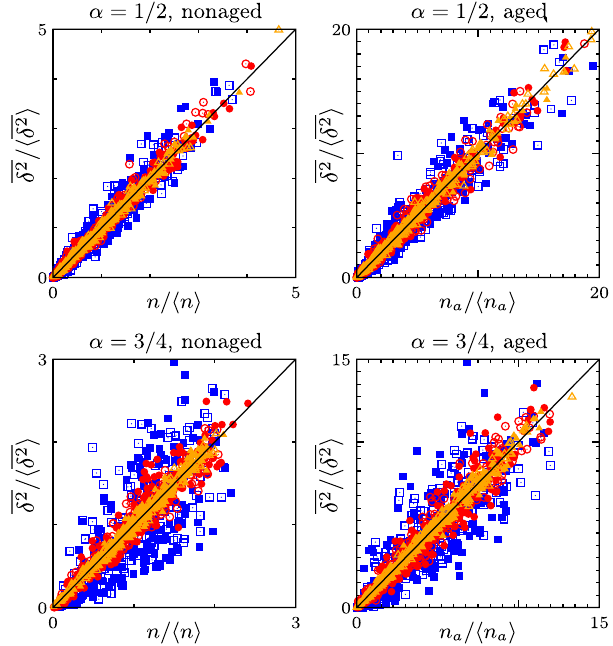
FIG. 5 (color online). Numerical demonstration of the asymp- totic identity (38) in the limit of long measurement times T ≫ Δ . While Δ ¼ 100 remains fixed, we compare T ¼ 2 × 10 5 (blue squares), T ¼ 2 × 10 6 (red bullets), and T ¼ 2 × 10 7 (orange triangles), demonstrating convergence. Each point in the graph represents an individual CTRW trajectory. Full symbols represent free CTRW, open symbols are for motion bounded by a box. t either 0 (nonaged) or for specific α and T chosen such that m α ð t =T Þ ¼ 0 . 21 (aged). The simulation data are extensive a enough as to ensure that every system is represented by roughly 200 points with δ 2 > 0